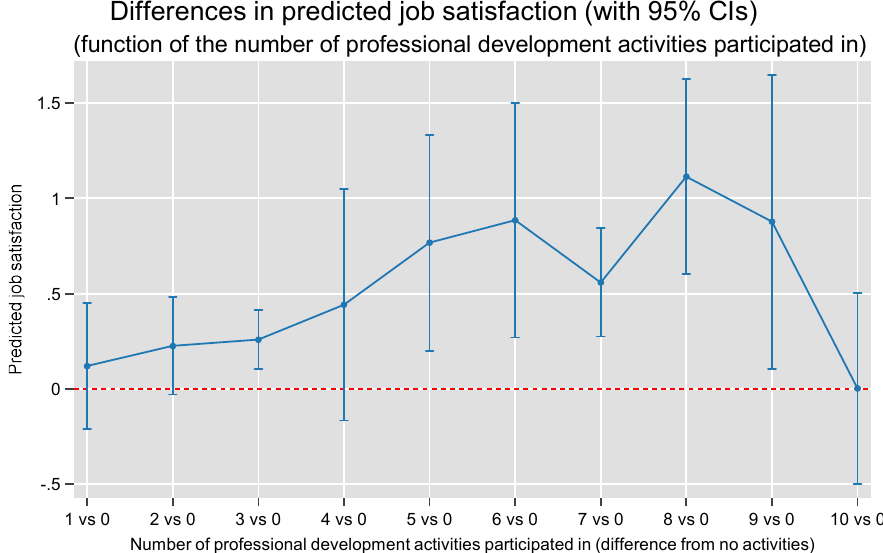
Figure 4. Differences in predicted job satisfaction as a function of the number of professional development activities participated in, compared to no participation.